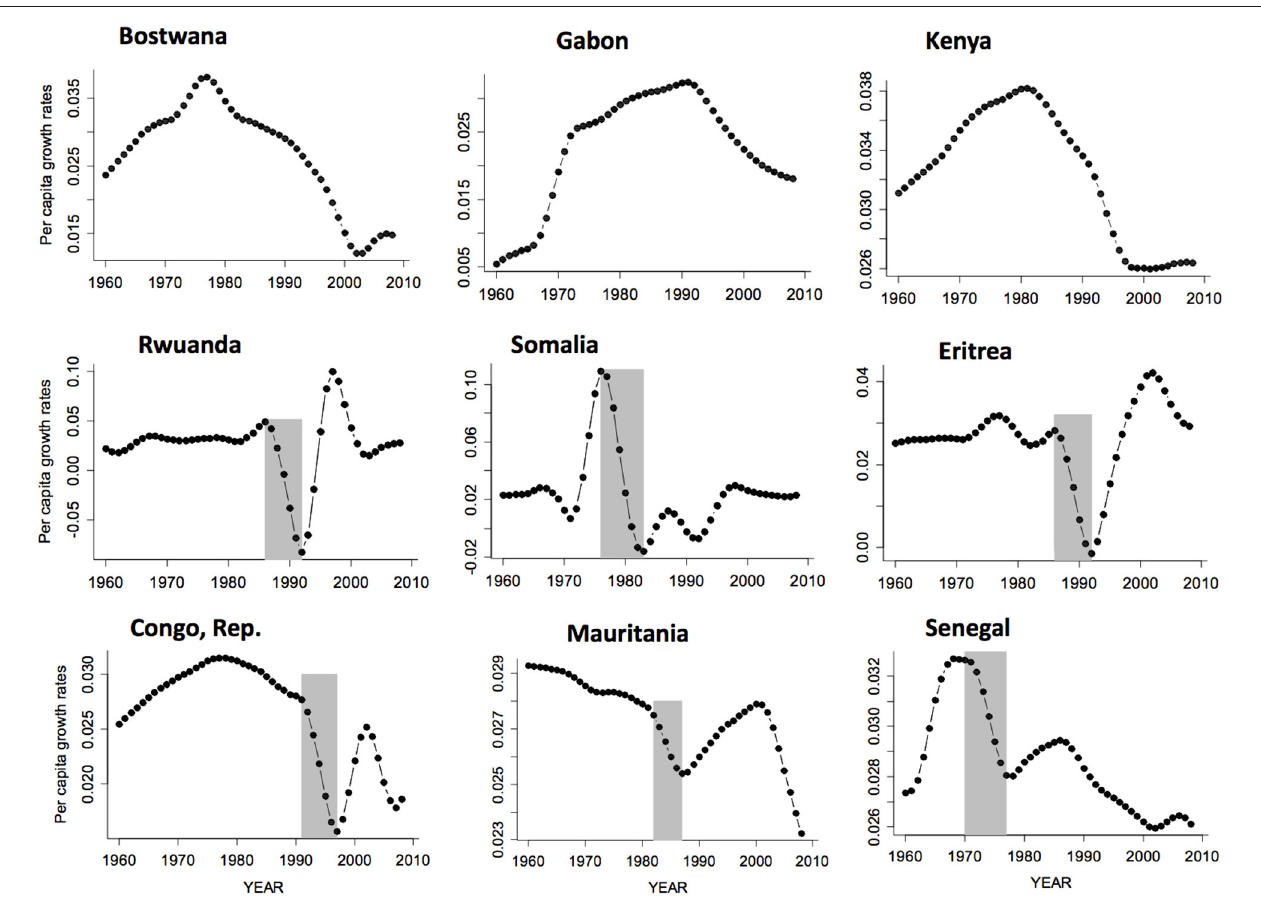
FIGURE 1 | Annual estimates of per capita growth rates [ R ] of the African human population during the period 1960–2010. First row: examples of Sub-Saharan Africa (SSA) countries showing no population consequences of civil wars; second row, SSA countries exhibiting strong population effects; third row, SSA countries showing mild population effects of civil warfare. Gray stripes represent phases with sudden decreases in per capita growth rates: the magnitude of which is estimated by the difference between the initial and final value of these